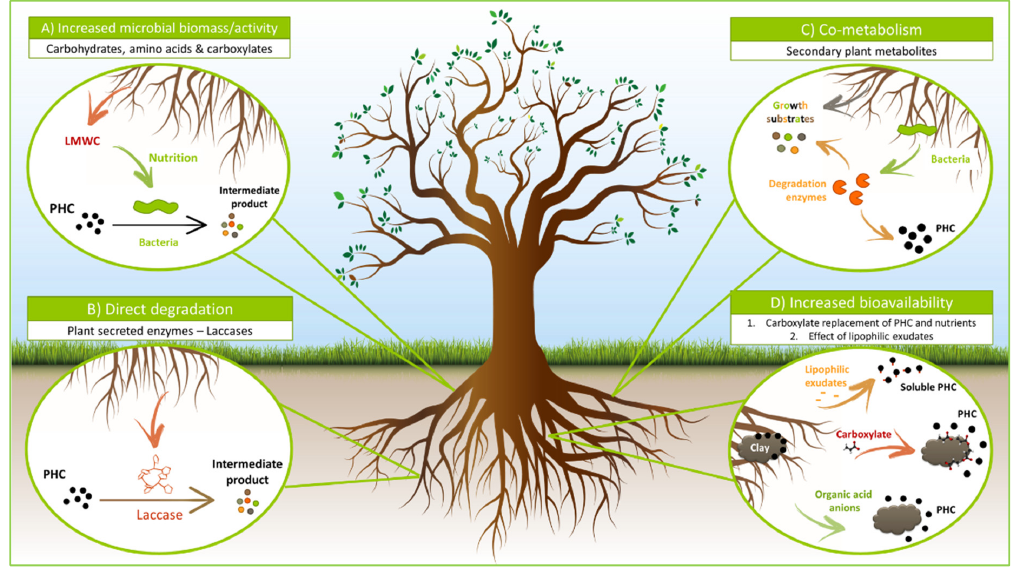
Figure 3. Improvement of petroleum hydrocarbon degradation by root exudates. PHC: Petroleum hydrocarbon; LMWC: Low molecular weight compounds. Adapted from Martin et al. [54].